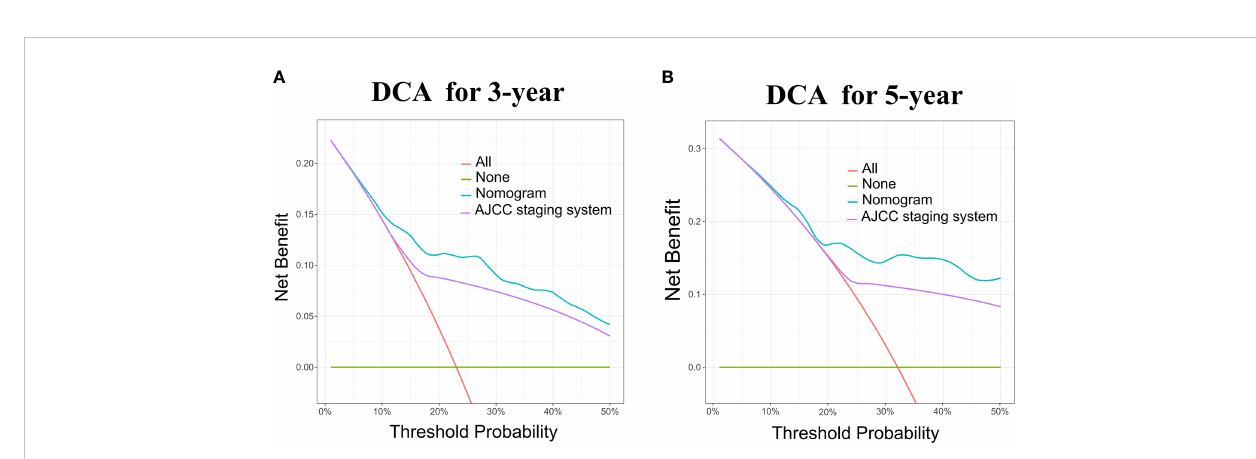
FIGURE 6 DCA for the Nomogram and AJCC staging system in the validation cohort. DCA in the prediction of patients at 3-year (A) and 5-year (B) in the training and validation I